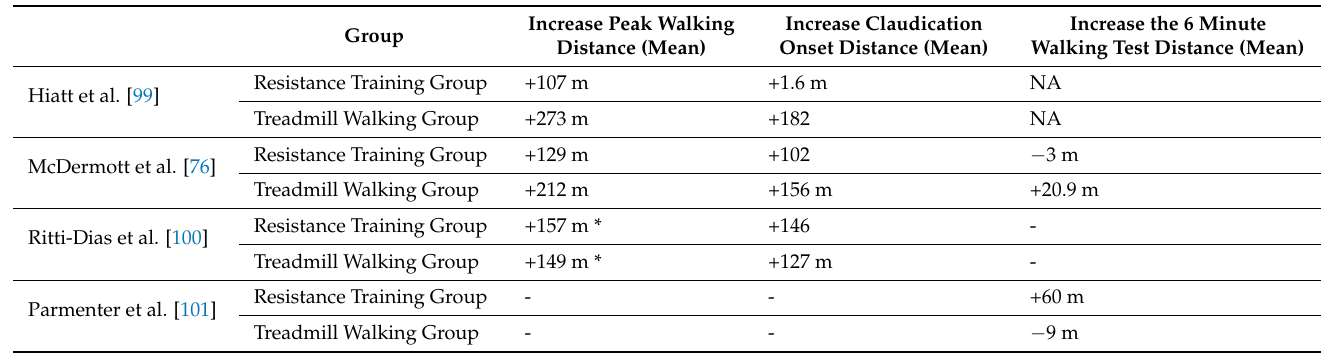
Table 4. Comparison of resistance exercise training programs in patients with PAD. High-intensity resis- tance training is superior to treadmill exercise training in improving walking distance in PAD patients. Increase Peak Walking Increase Claudication Increase the 6 Minute Group Distance (Mean) Onset Distance (Mean) Walking Test Distance